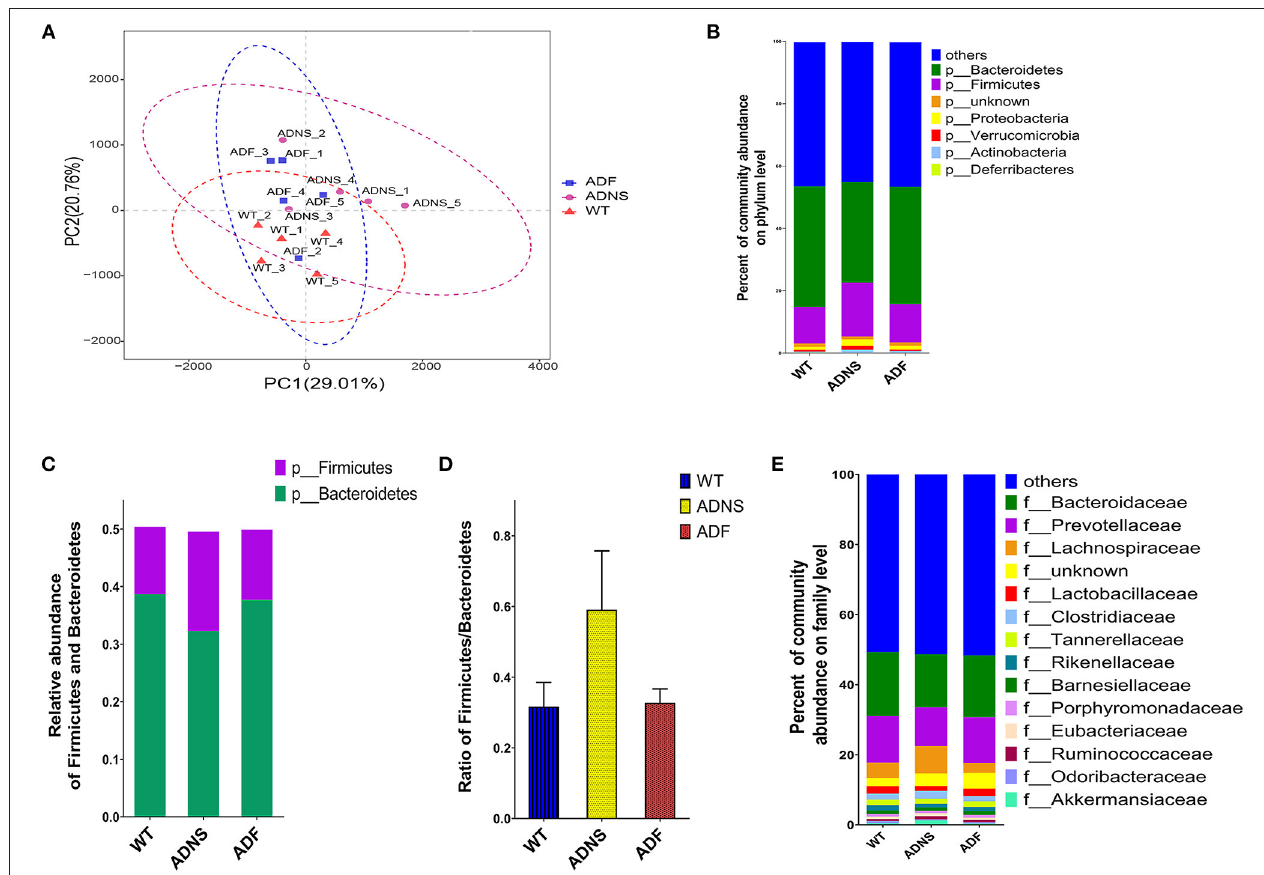
FIGURE 3 | Microflora alteration in WT and APP/PS1 mice treated with fasudil. (A) Comparison of microbiota based on species composition by principal component analysis (PCA) in WT (red triangles) and APP/PS1 mice treated with saline (ADNS, purple circles) or fasudil (ADF, blue squares). The colored ellipses indicate 0.95 confidence interval (CI) ranges within each tested group. The scale of the horizontal and vertical axes refers to a relative distance. PC1 and PC2 represent the suspected influencing factors for the deviation of the species composition of samples. The closer the distance between the two points represents the smaller the difference of species abundance composition between the two samples. The data indicate ADF is closer to WT than ADNS. (B) The dominant representation in phyla. WT, ADNS, and ADF were colored at the phylum level on a stream graph. Bacteroides (green) and Firmicutes (purple) were the two most abundant bacteria at the phylum level. (C,D) The two most abundant phyla of Bacteroidetes and Firmicutes. The columns indicate the abundance of Bacteroidetes (green) and Firmicutes (purple) (C) . The ratio of Firmicutes/Bacteroidetes was increased in ADNS compared to WT, which was reversed in ADF (D) , indicating an alteration in the types